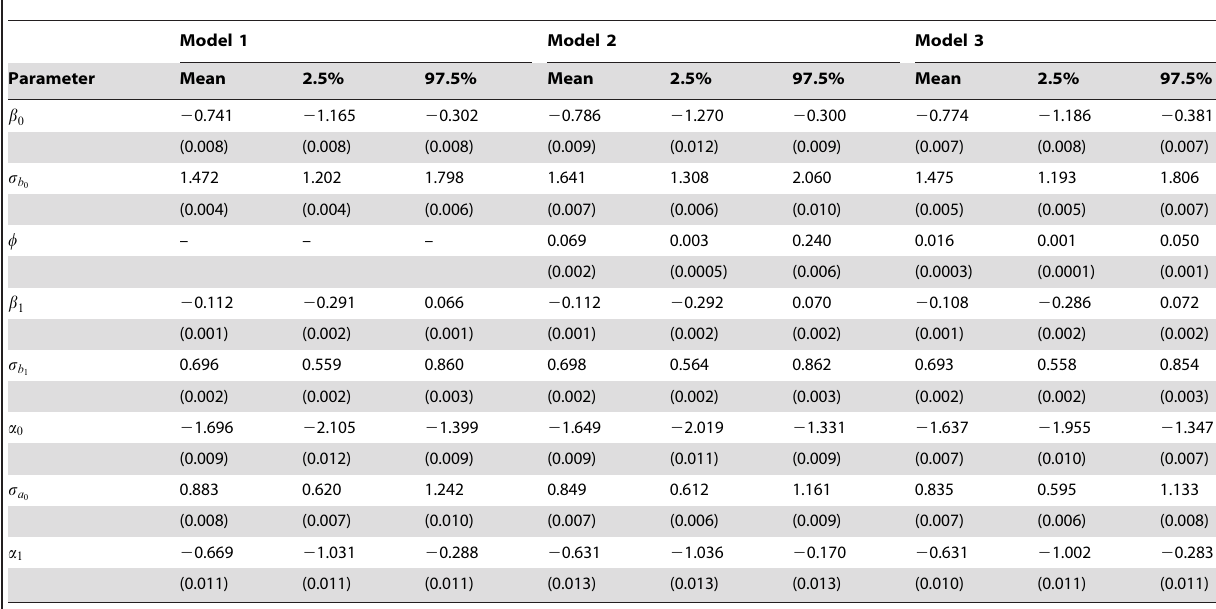
Table 1. Posterior means and 95% credible intervals for the parameters of three